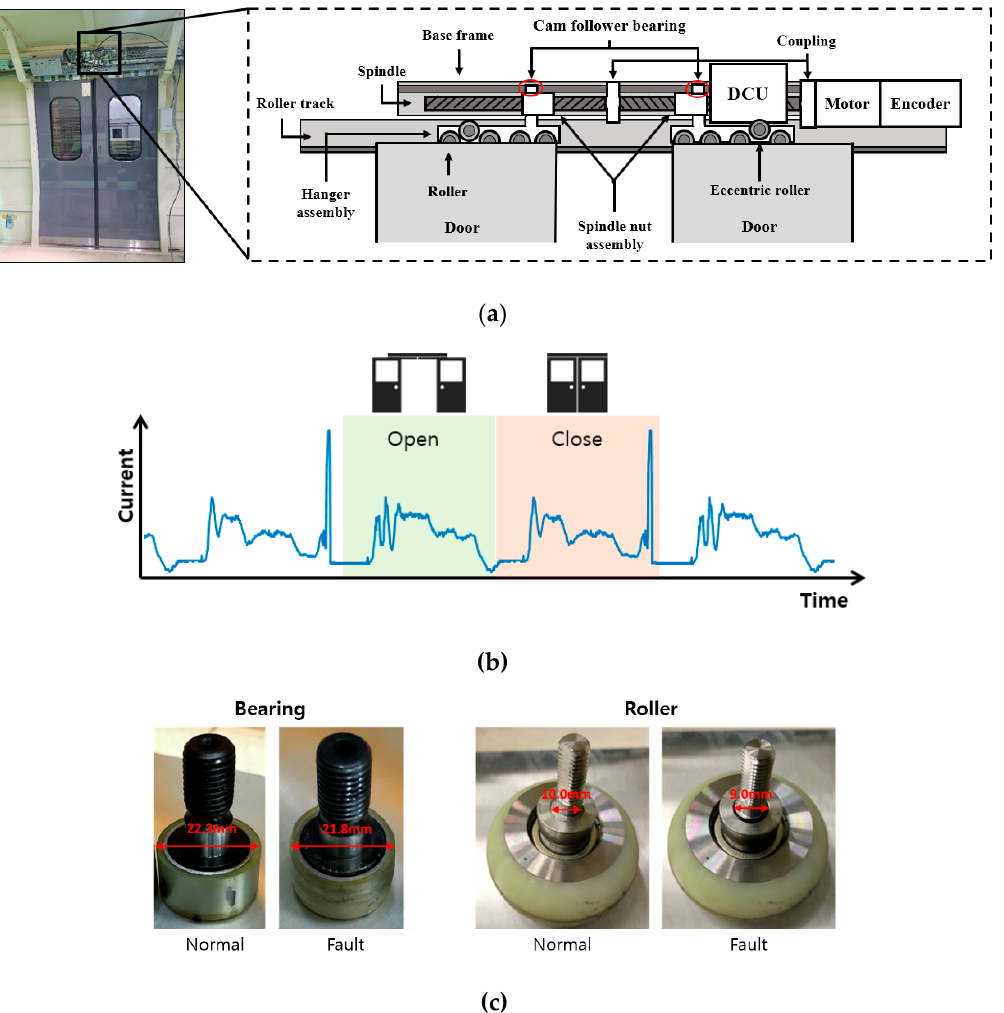
Figure 2. Data acquisition: ( a ) Train door system test rig; ( b ) current signal during operation; ( c ) bearing and roller specimen for test.